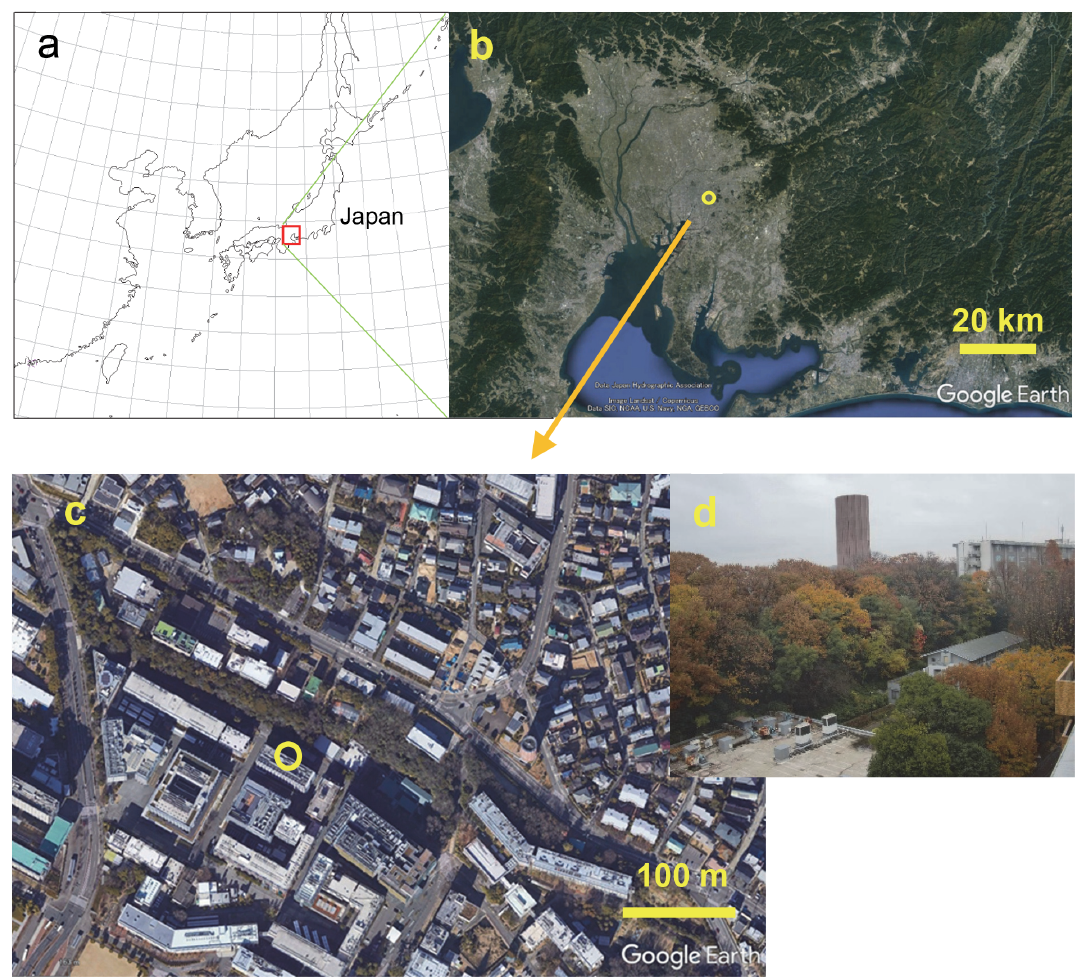
Figure 1. (a) Map of the area around the observation site. (b) Satellite image (from © Google Earth) near Nagoya University (open circles – 35.67 ◦ N, 139.83 ◦ E) in Nagoya, Japan. A local meteorological station (air temperature, relative humidity, rain, wind speed and direction, solar radiation, and weather records) and a national air pollution monitoring site (NO x and CO) are located at about 2km north of the site. (c) © Google Earth. Close-up view of the campus. NH x measurements were taken at the Environmental Studies Hall (open circle in c ). (d) Outside view from the seventh floor (26m above the ground) to the northeast, taken in early